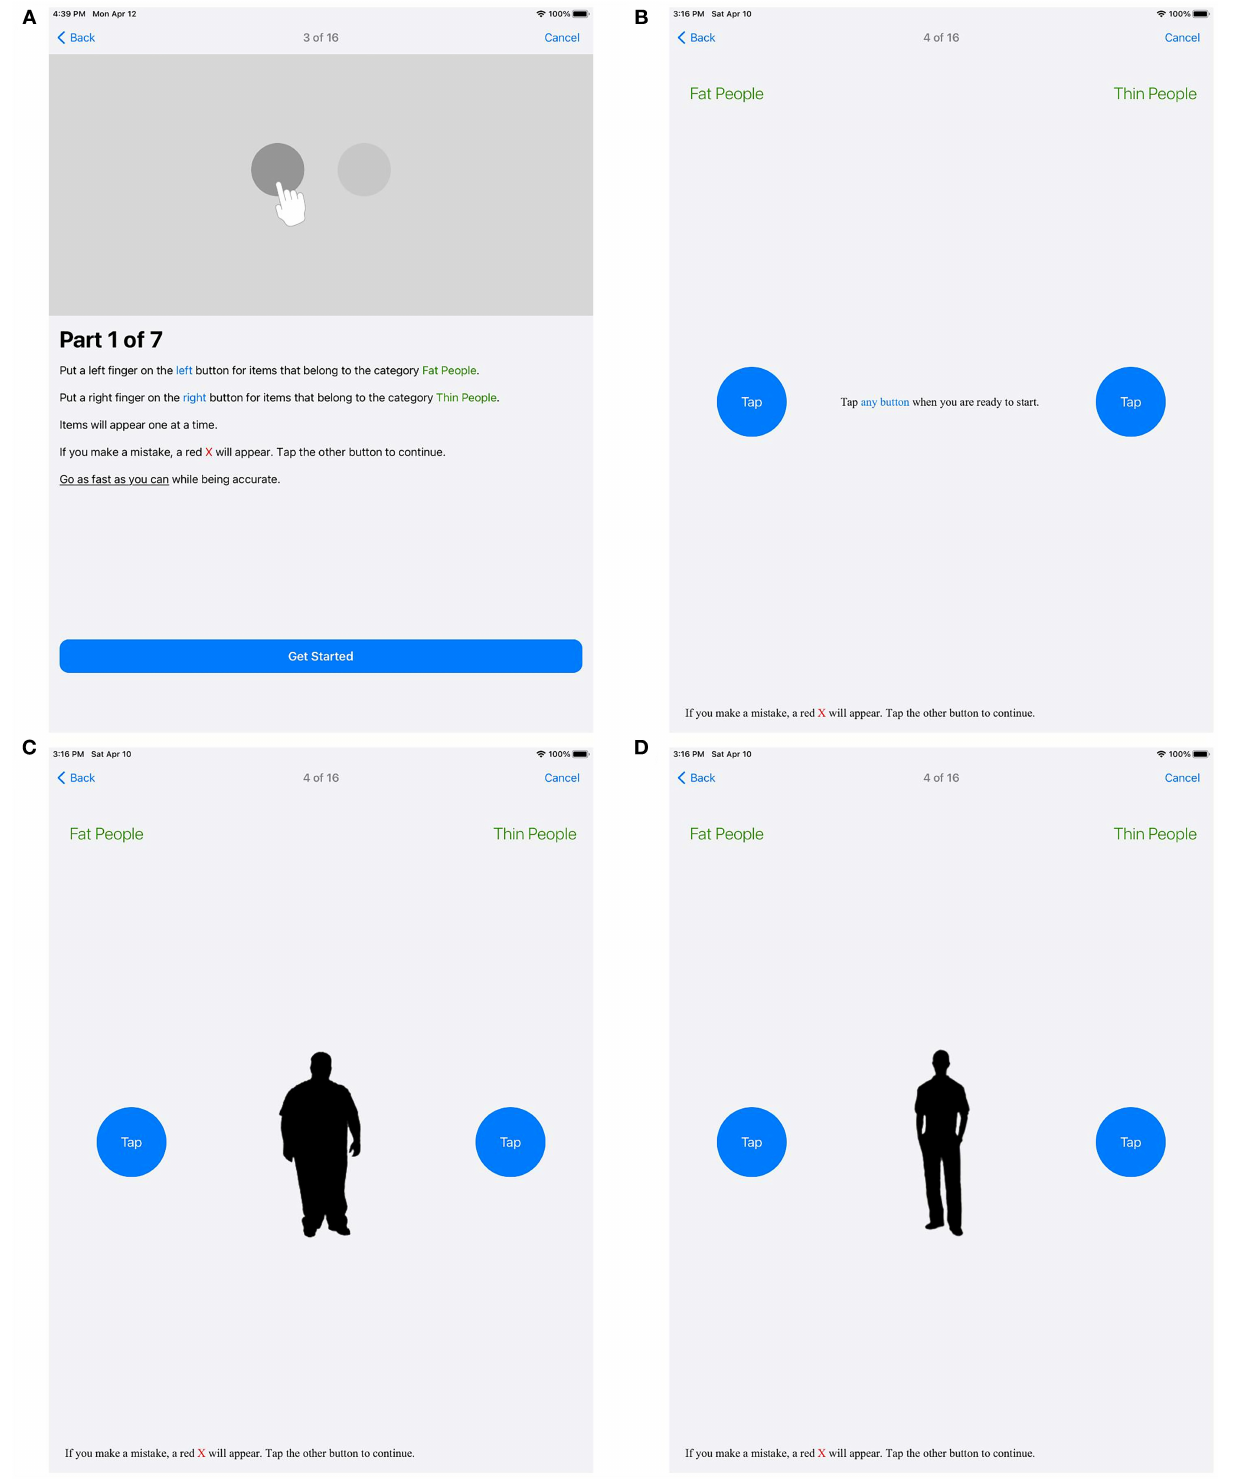
Frontiers in Digital Health |